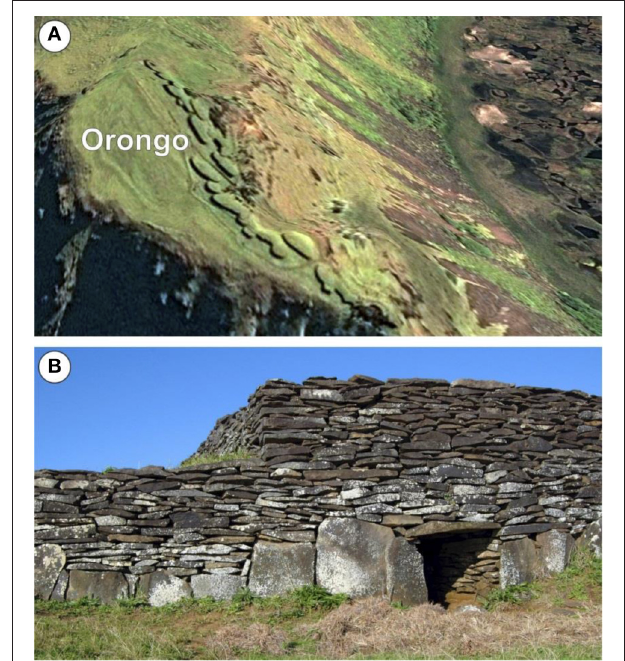
FIGURE 4 | The ceremonial village of Orongo at the SW rim of the Kao crater. See Figure 7 for the precise location. (A) Google Earth view showing the typical ellipsoidal boat-shaped stone houses. (B) Close front view of a typical stone house (Photo: N. Cañellas).